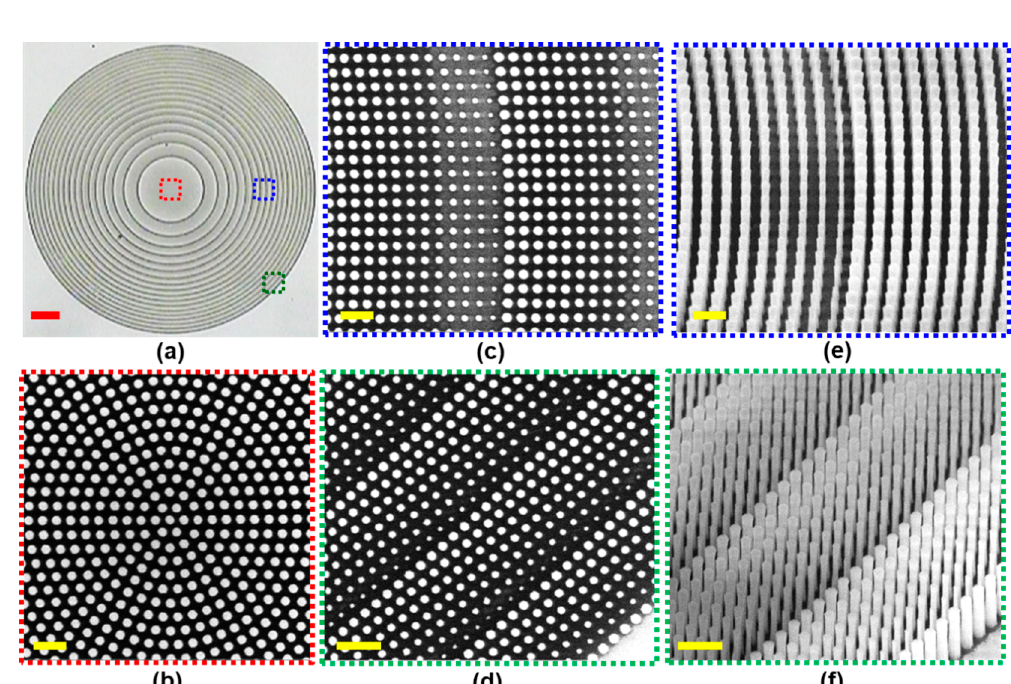
Figure 2. ( a ) The OM image of the fabricated metalens, scale bar: 10 µ m; ( b – d ) top-view SEM images associated the color-dashed squares in ( a ), scale bar: 500 nm; and ( e , f ) tilt-view SEM images associated the color-dashed squares in ( a ), scale bar: 500 nm.